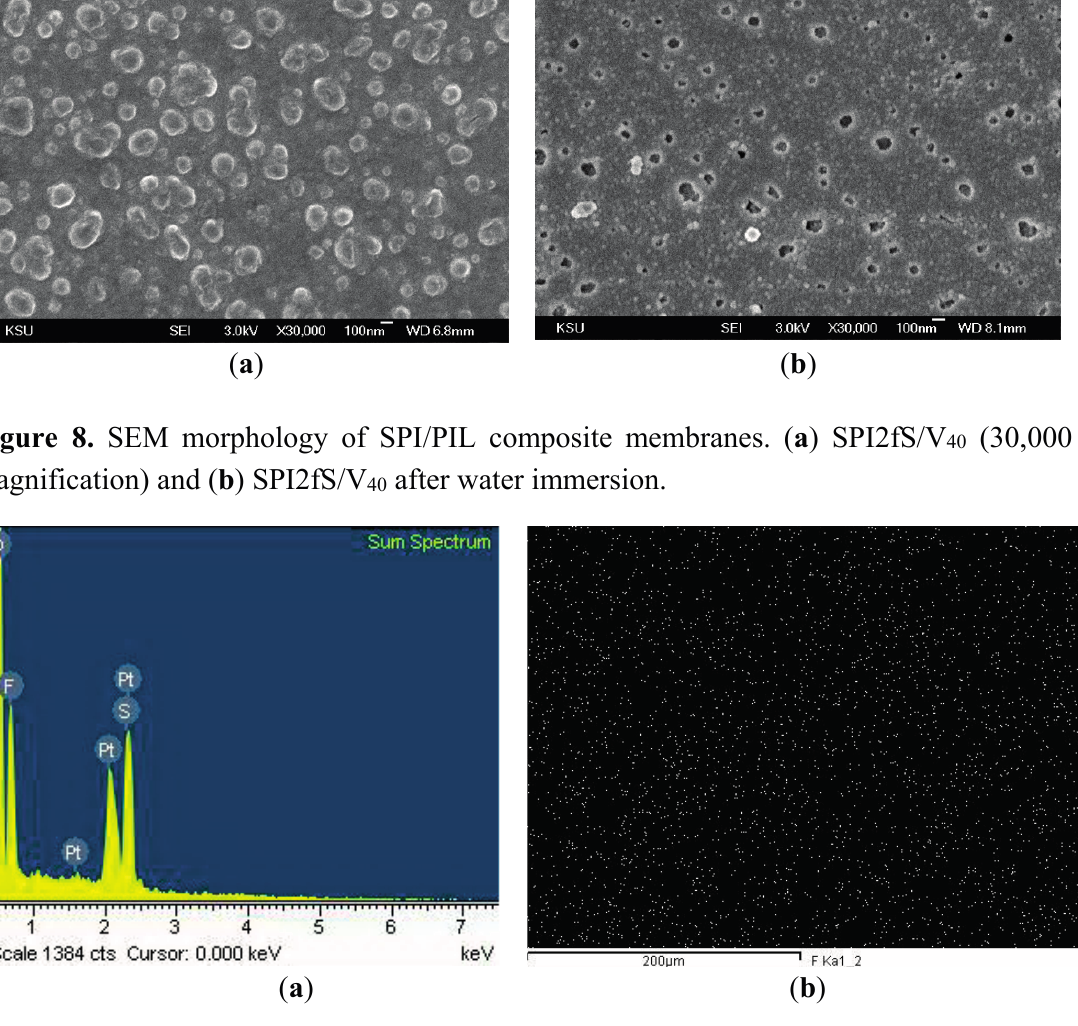
Figure 9. ( a ) EDS spectrum and ( b ) F mapping of SPI2fS/V 40